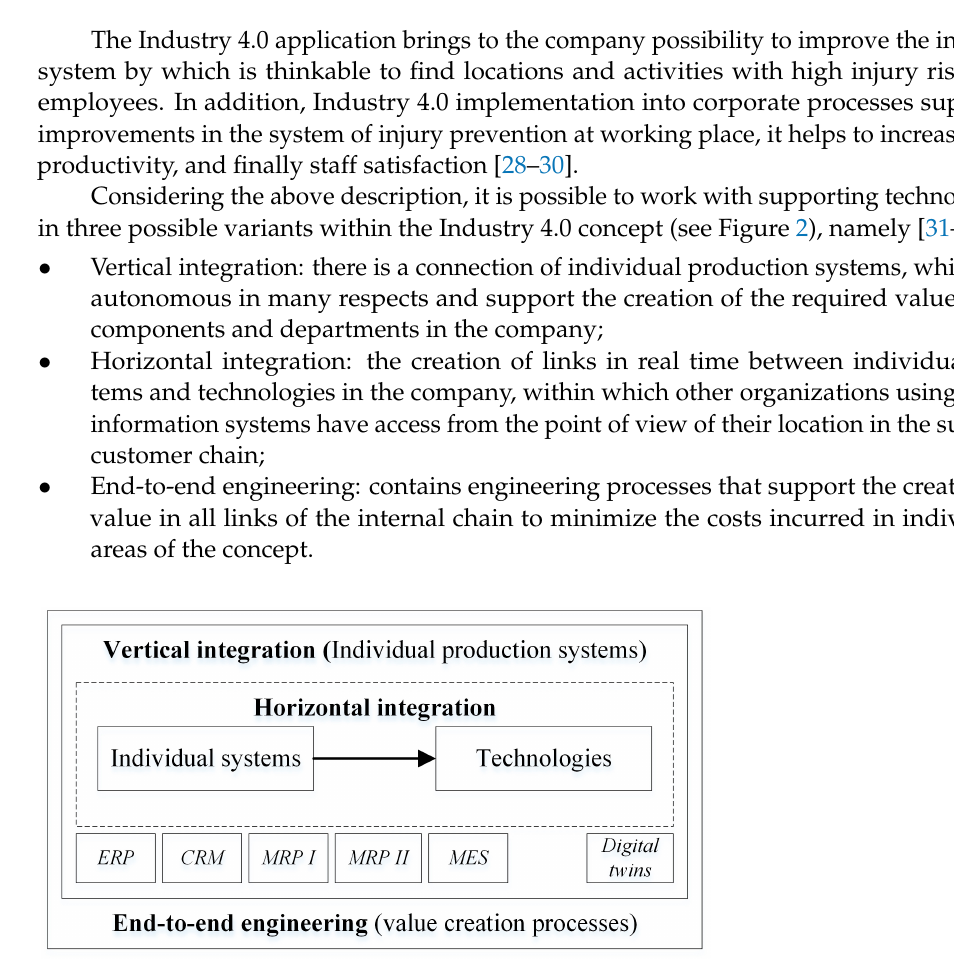
Figure 1. Specific areas of Industry 4.0 supporting the value creation.